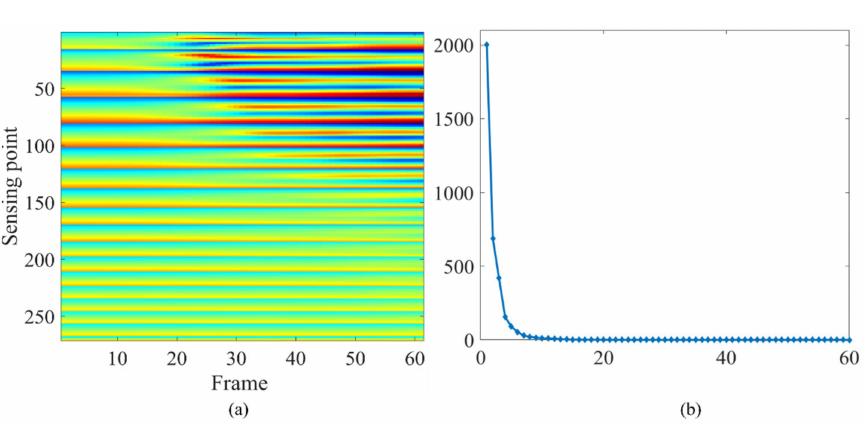
Figure 4. The fully sampled radial velocity map ( a ) and its singular values ( b